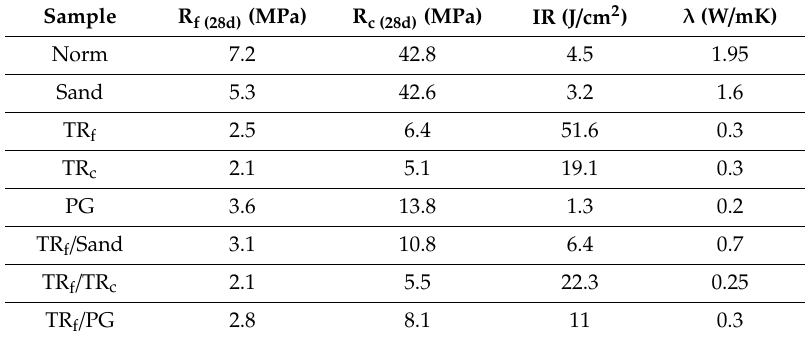
Table 3. Main results from flexural (R f ), compressive (R c ), impact resistance (IR) and thermal tests ( λ ). Sample